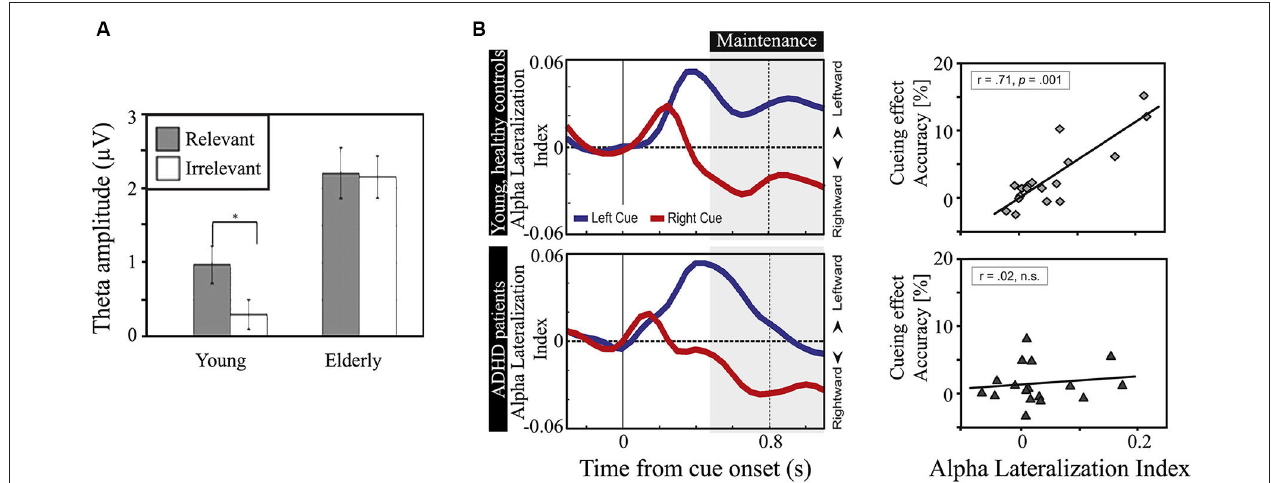
hemisphere versus the task-relevant contralateral hemisphere. While young, healthy adults are able to modulate their alpha lateralization symmetrically around zero, inattentive ADHD patients show a lack of maintaining a high degree of alpha lateralization to the left side. In addition, there is an absence of correlation between alpha lateralization index and behavioral cueing effect in ADHD patients, whereas there is a strong relationship in healthy, young adults. Reproduced with permission from ter Huurne et al.